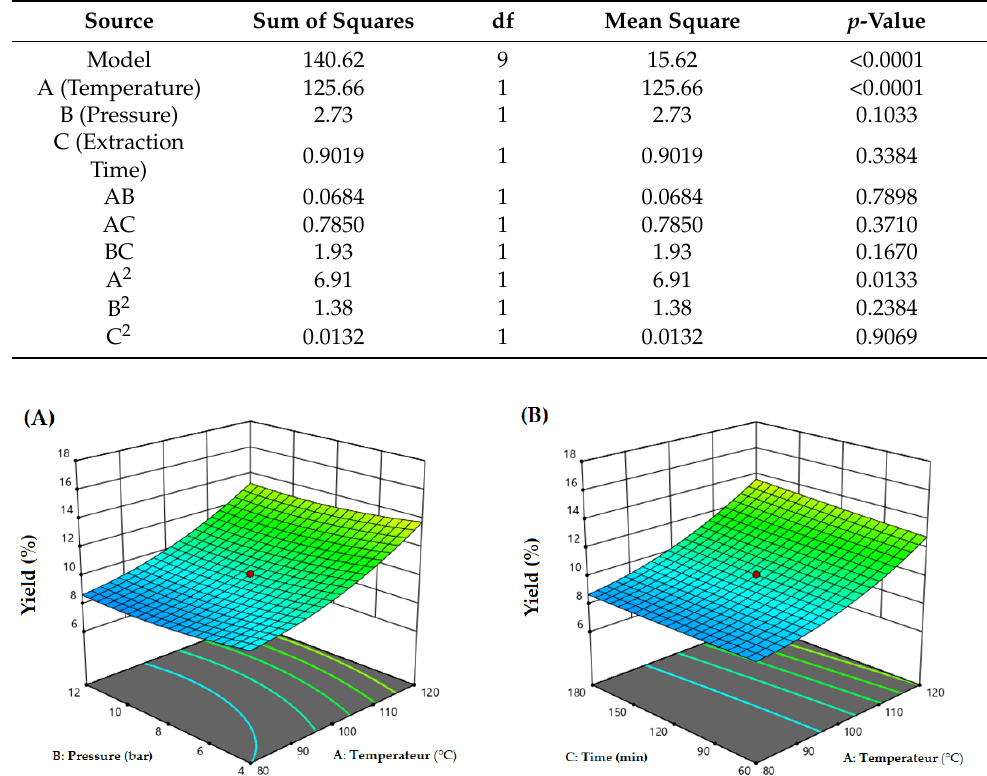
Table 4. Optimal conditions for SCGs extraction with pressurized hot water and the predicted and the actual values of